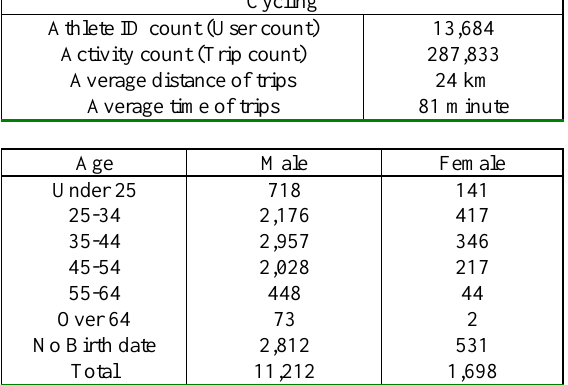
Table 2. Demographics of cycles of Strava users in 2015.